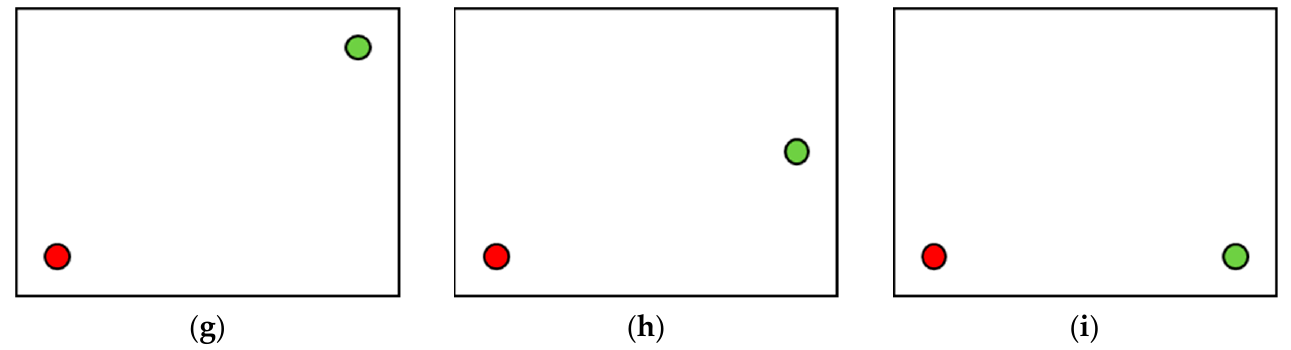
Figure 18. Final output: ( a ) set #1; ( b ) set #2; ( c ) set #3; ( d ) set #4; ( e ) set #5; ( f ) set #6; ( g ) set #7; ( h ) set #8; ( i ) set #9.